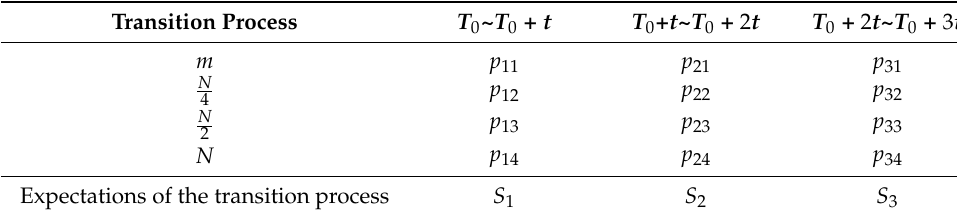
Table 1. The prediction probability of phased equipment